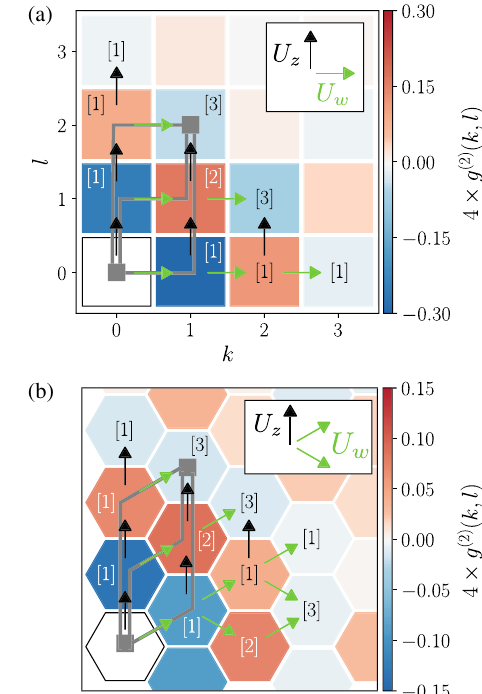
FIG. 11. Illustration of the different paths connecting two sites with a distance ð k; l Þ contribution to the leading-order short-time expansion on (a) the square lattice and (b) the triangular lattice. The number in brackets shows the binomial coefficient C j k jþj l j (assuming k; l ≥ 0 ) corresponding to the number of distinct paths. The arrows show the potentially different couplings along paths contributing to the short-time expansion. The grey lines show the three distinct paths contributing to the correlation indicated by a grey square, as an example.